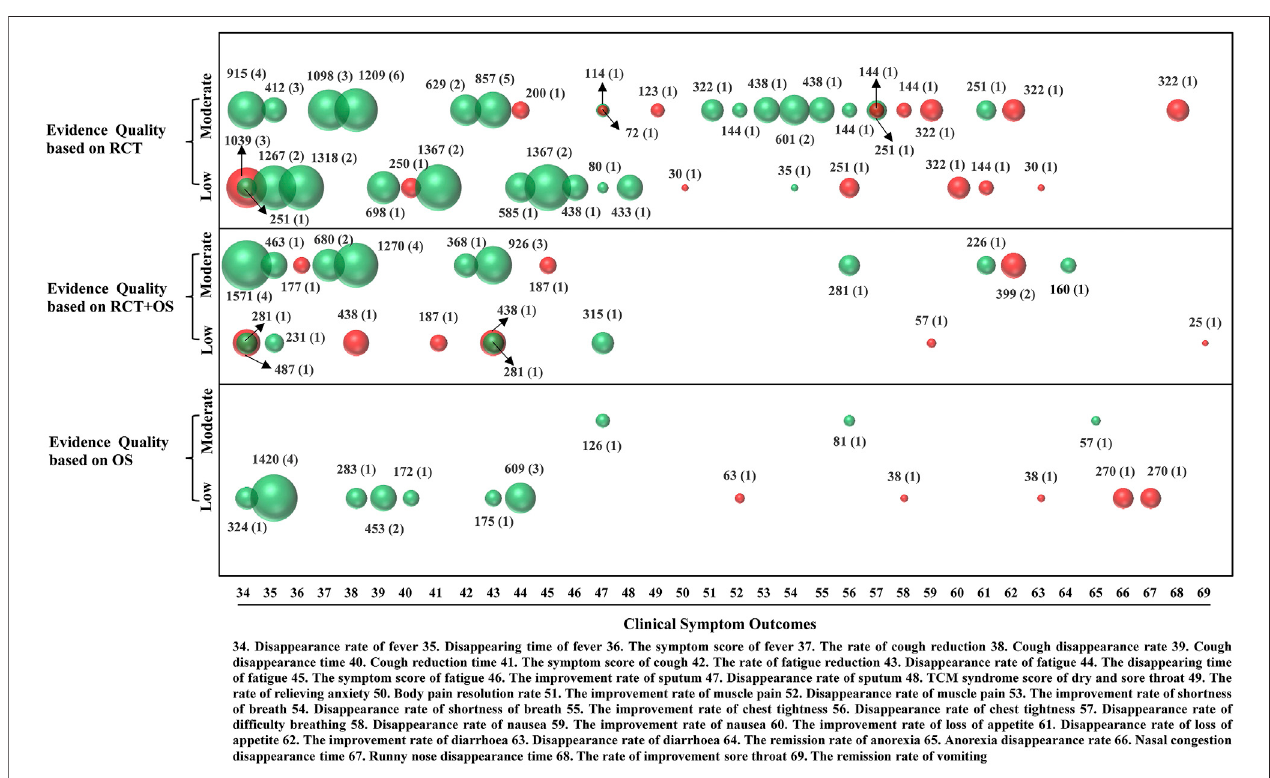
FIGURE6| Mappingofevidencequalityofclinicalsymptomoutcomes.EachbubblesizerepresentspatientsincludedintheSRs,greencolorrepresented p < 0.05, and red color represented p > 0.05. The outcomes were represented on the lateral axis, whereas the evidence quality was represented on the vertical axis.